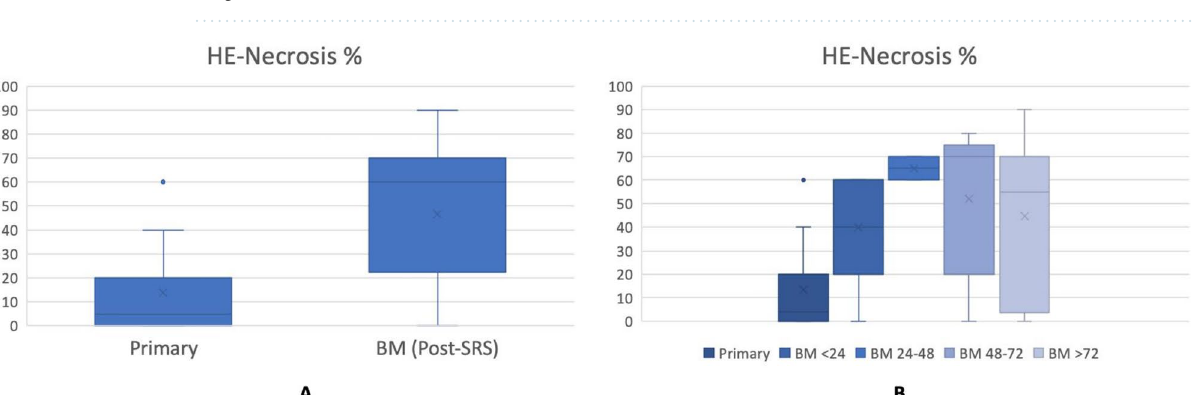
Figure 1. Representative tissue samples displaying the acute effects of stereotactic radiosurgery in brain metastasis. Hematoxylin and eosin staining showing necrosis of a primary tumor (NSCLC) sample ( A ); primary tissue sections were immunohistochemically stained for CD3 + ( B ), CD4 + ( C ), and CD8 + ( D ) cells. Hematoxylin and eosin staining demonstrated an increase in necrosis in the paired resected brain metastasis after pre-operative SRS ( E ). Additionally, a decrease in all immunomodulatory cell populations, including CD3 + ( F ), CD4 + ( G ), and CD8 + cells ( H ) were observed on pairwise comparison. (Original magnification × 40).